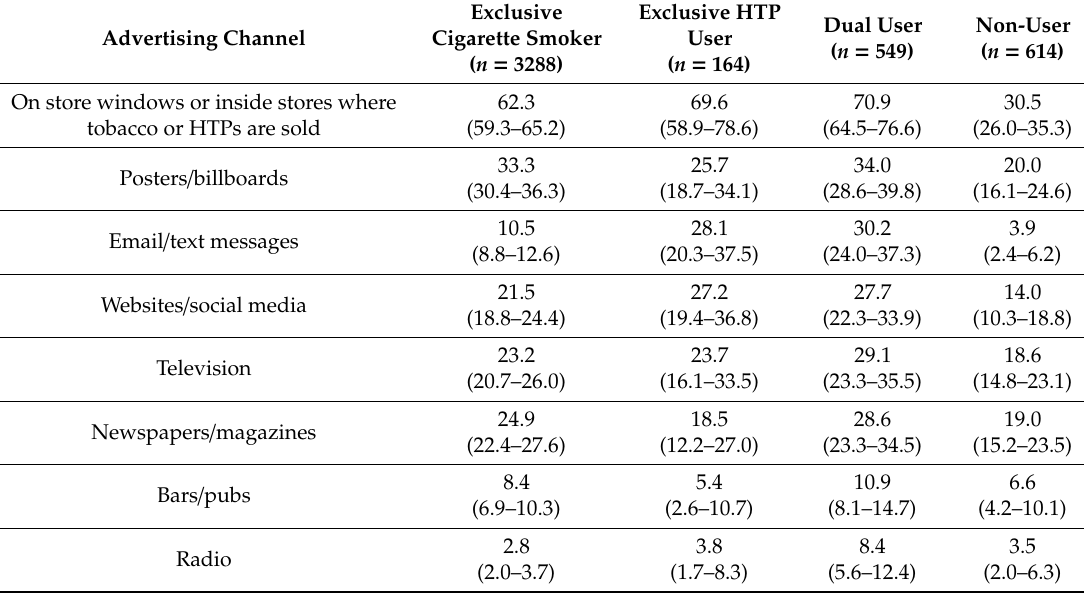
Table 2. Percentage of Respondents (and 95% CI) who Reported Noticing Advertising of HTPs in the Past Six Months by Channel and User